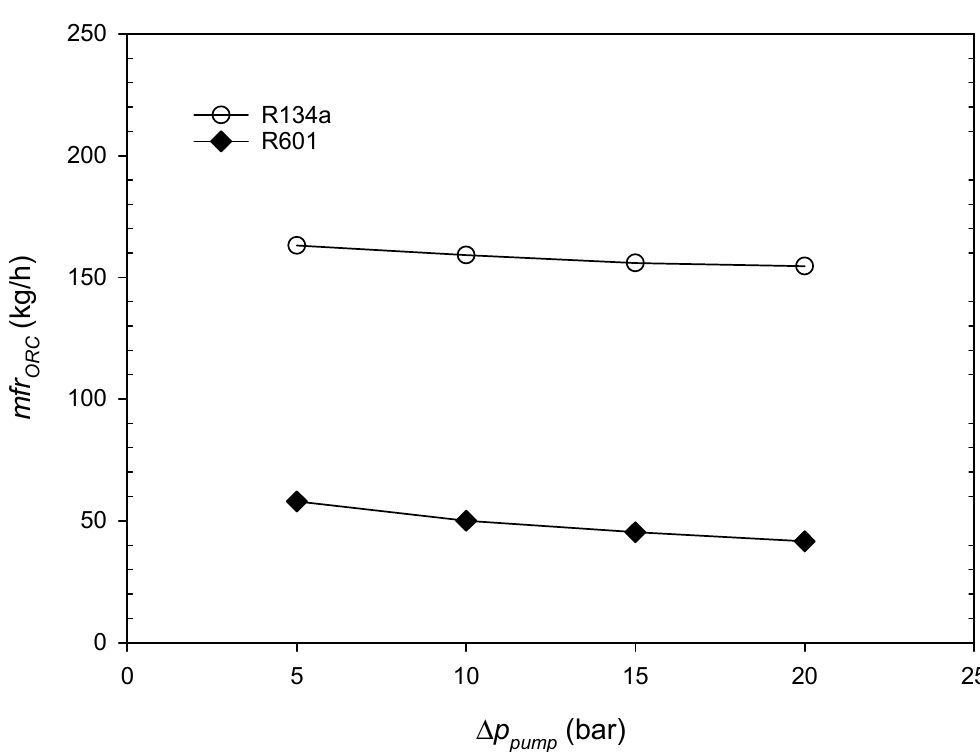
Figure 8. Working fluid mass flow rate as a function of pump pressure increase, grid point 6.